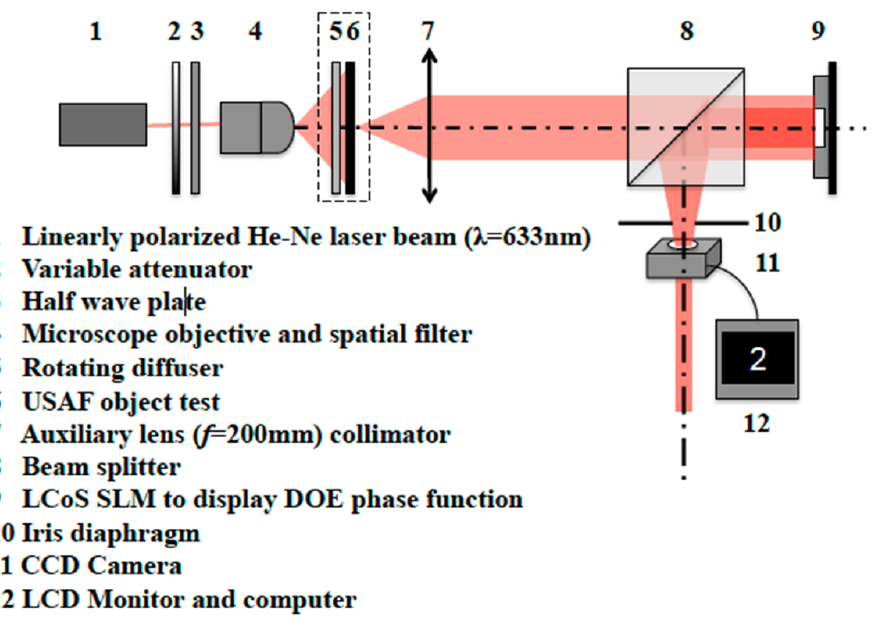
Figure 1. Experimental setup to evaluate the EDOF DOE displayed on the phase-only SLM (element 9). Element 5 is introduced for incoherent illumination. Element 6 is the large-object test from which character 2 (the one that identifies group 2 in the 1951 USAF resolution test chart) is taken for the image-forming experiments. To obtain the PSF, elements 5 and 6 were removed, and element 4 (microscope objective and spatial filter) was moved forward to reach the front focal plane of the collimator (element 7). This way, the image intensity of the point-source at infinity was registered with the CCD sensor (element 11). The iris diaphragm (element 10) limited the square aperture of the SLM to a circular pupil.